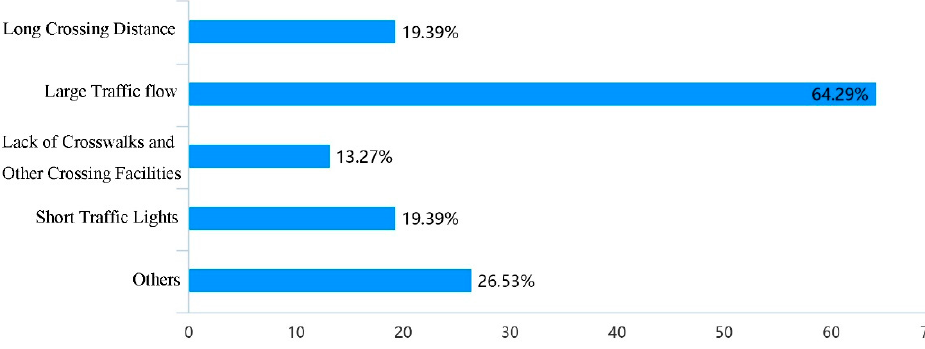
Figure 7. Factors causing unsafe crossing of the current school travel road.